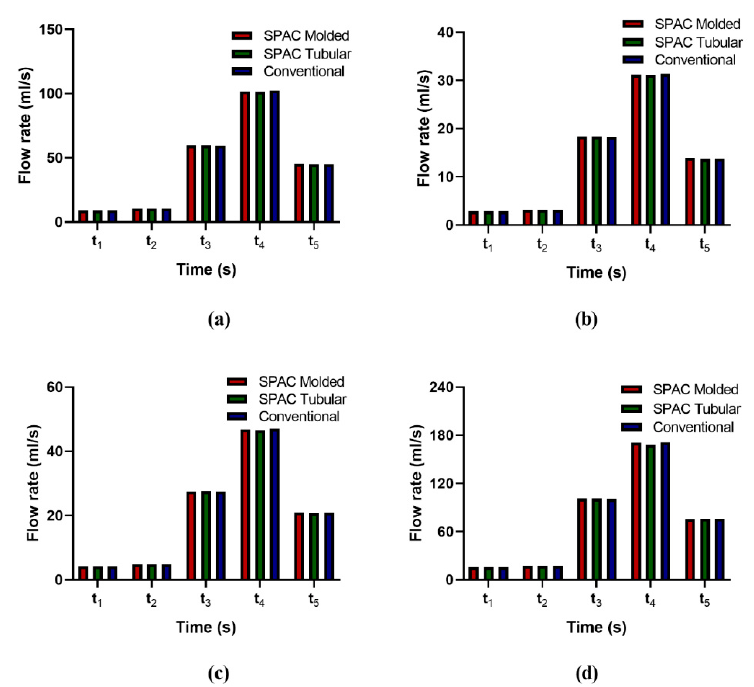
Figure 4. The e ff erent flow rates of three cases at ( a ) abdominal aorta, brachiocephalic artery (BA), ( b ) left common carotid artery (LCCA), ( c ) left subclavical artery (LSA) and ( d ) aortic arch, descending aorta